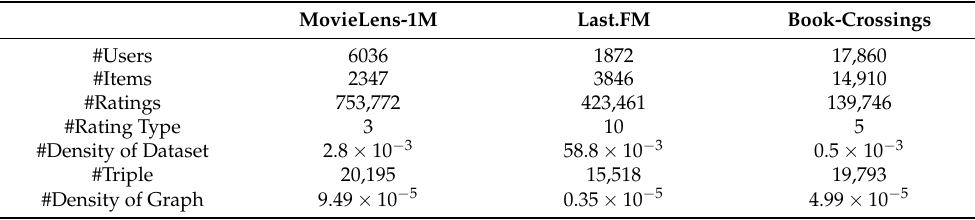
Table 1. Basic statistics of the